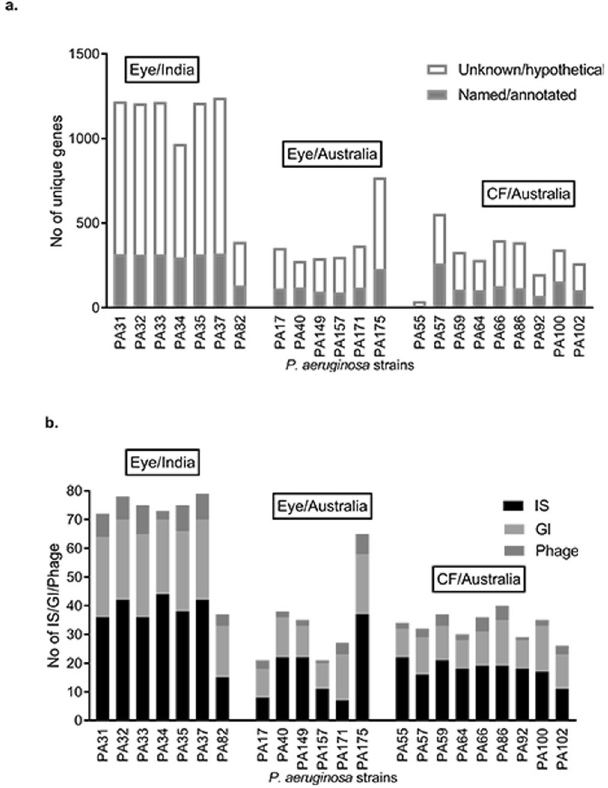
Figure 1. Composition of accessory genomes. ( a ) Distribution of unique genes. ( b ) Distribution of predicted no of insertion sequences (IS), genomic islands (GI) and